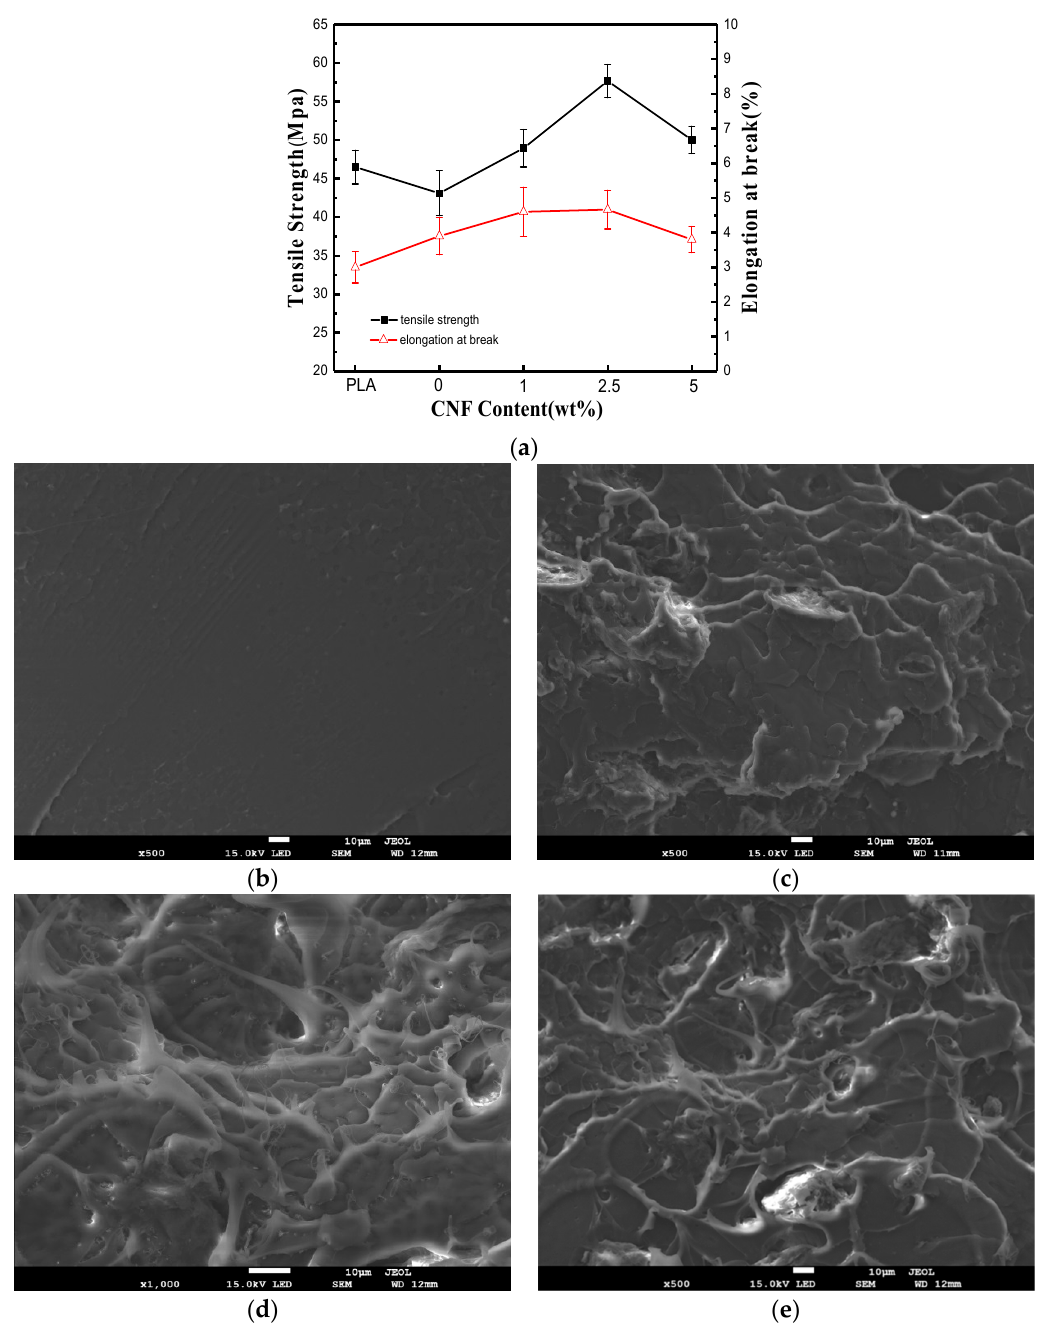
Figure 4. ( a ) Tensile properties of PLA / PEG / CNF composites with di ff erent CNF loading; ( b ) FE-SEM micrographs of cross-section of virgin PLA; ( c ) PLA / PEG / CNF 1 wt.%; ( d ) PLA / PEG / CNF 2.5 wt.%; ( e ) PLA / PEG / CNF 5 wt.%. Scale bar = 10 µ m.